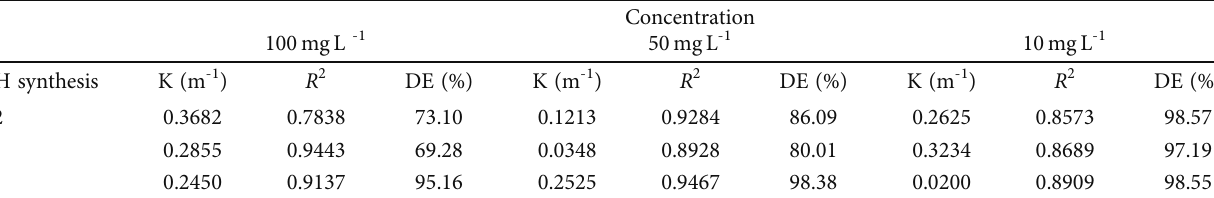
NPs at pH 12 (1a), 7 (2a), and 4 (3a), degradation e ffi ciency for TiO 2 NPs at pH 12 (1c), 7 (2c), and 4 (3c). 2 Table 1: Parameters of adsorption for the isotherm